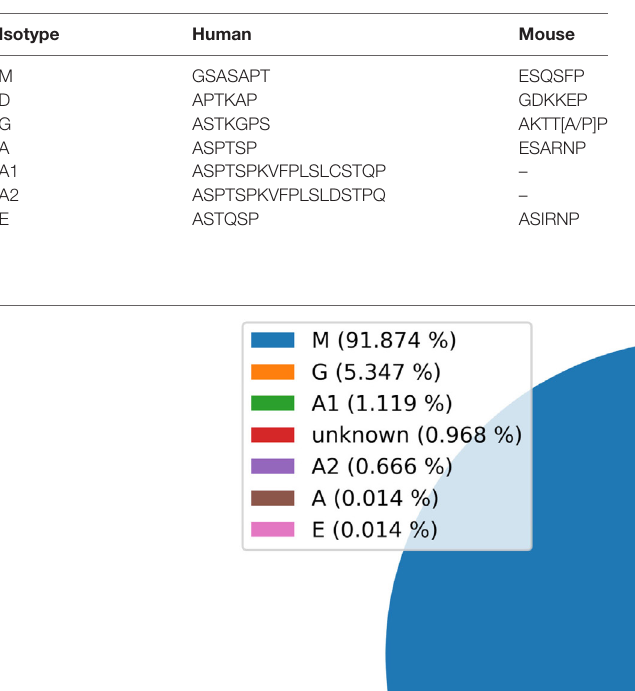
TABle 2 | The sequence fingerprint characteristic of each isotype in human and mouse.